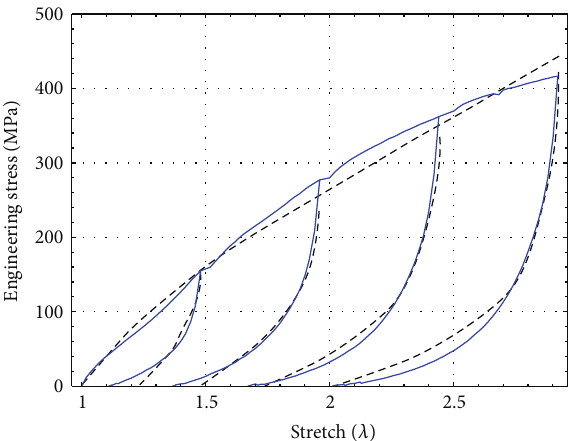
Figure 8: Engineering stress-stretch data for nylon sutures com- pared with theoretical predictions of the nonmonotonous amended average-stretch, full-network model for which 𝜇 = 155 MPa, 𝑁 = 20.5 , 𝑏 = 1 , and 𝐶 = 0.0035 MPa. The dashed black lines represent theoretical predictions, and the blue solid lines describe experimental data.